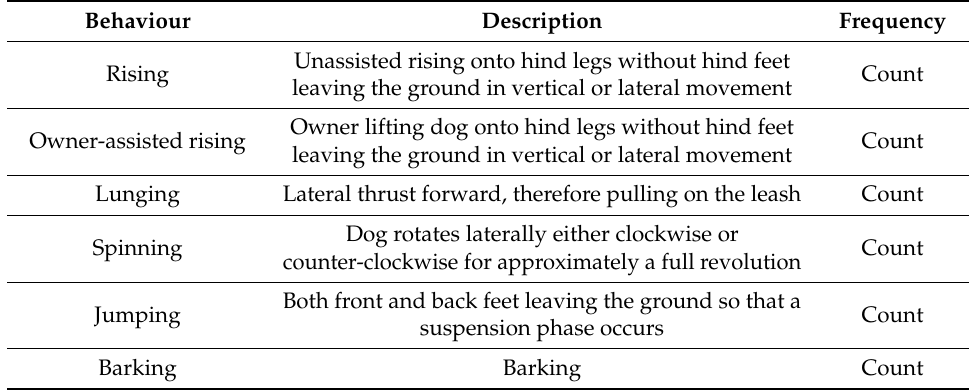
Table 1. Ethogram of all the behaviours potentially indicating arousal during stir-up in greyhounds.